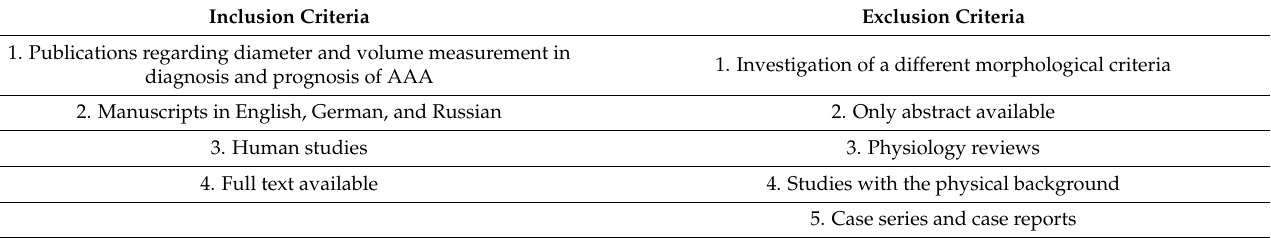
Table 1. Inclusion and exclusion criteria .